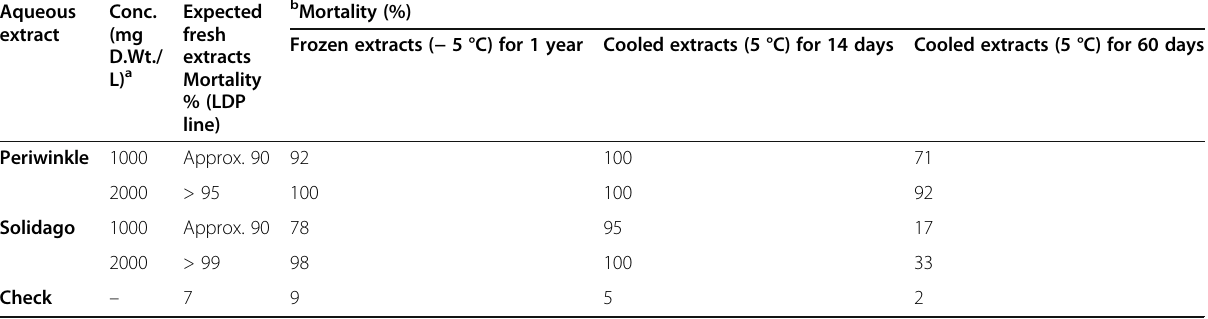
Number of dead J 2 in a treatment Number of totals tested J 2 in the same